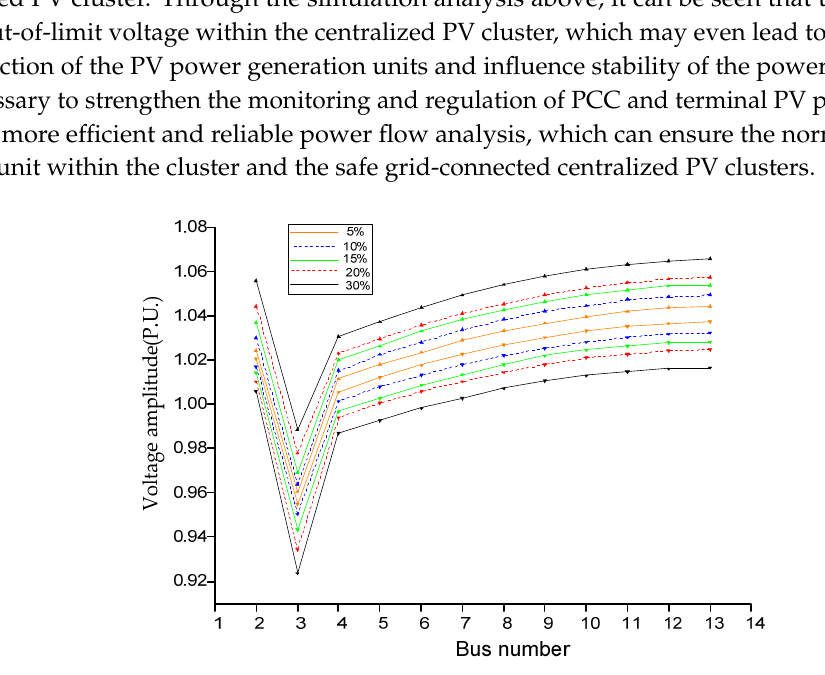
Figure 7. The voltage phase angle intervals under di ff erent